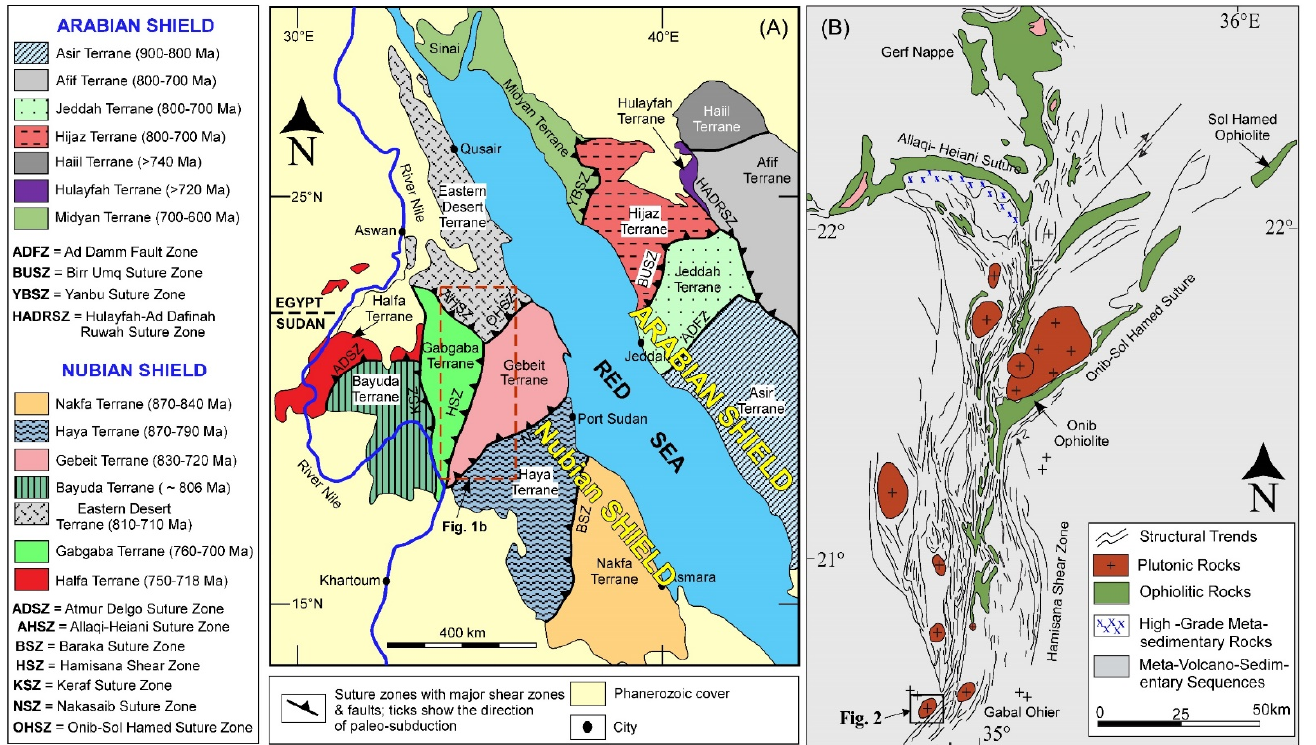
Figure 1. ( A ) The ANS geological and structural map [13,15] shows tectonostratigraphic terranes with estimated terrane protolith ages, as well as subduction directions, suture zones, and boundaries between the ANS and bordering older crustal blocks. The dashed line red rectangular is the HSZ, marked as b: ( B ) general geologic map of the plexus, including the eastern part of the Gerf nappe, the Onib–Sol Hamed suture, the Allaqi–Heiani suture, and the HSZ [16]. The structural trends represent field structural data measured by Stern et al. [16] and they represent a combination of low angle thrust fault, deformations, dextral shears, and folded structures.